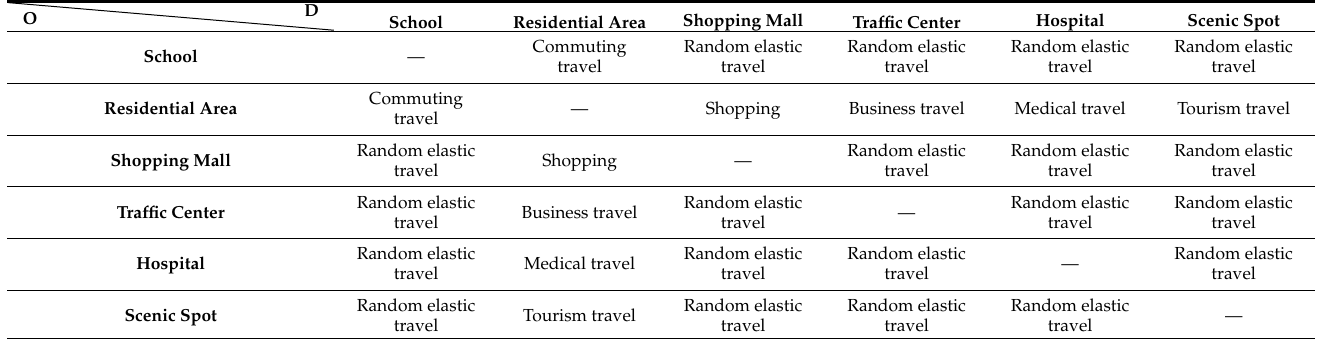
Table 1. Division of the residential travel